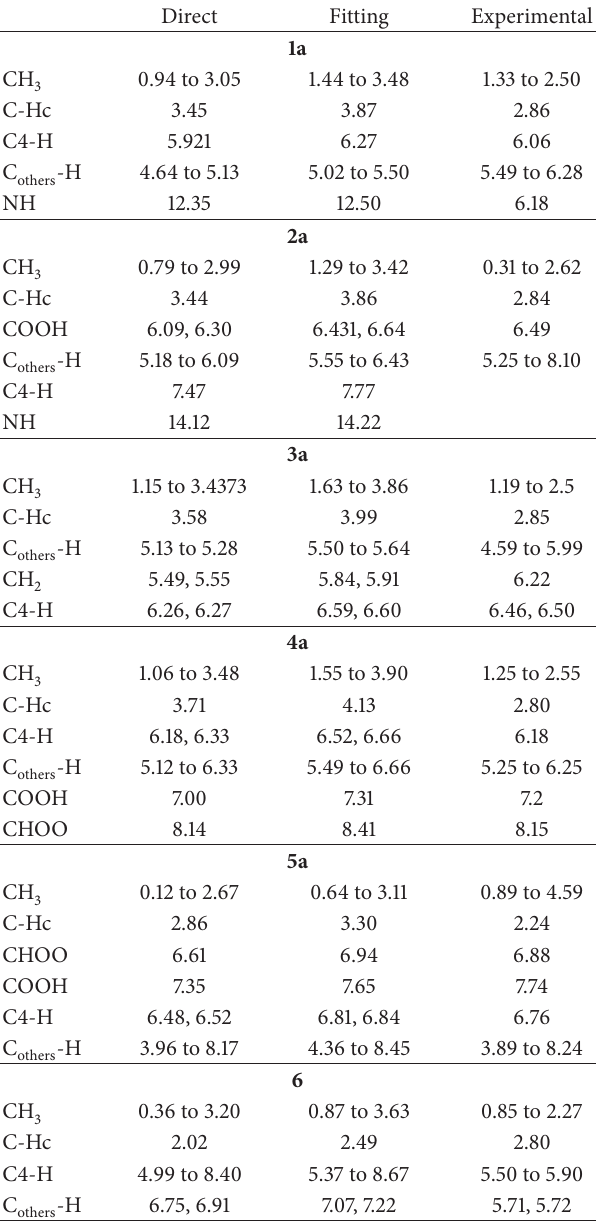
Table 3: The experimental and the theoretical (direct and fitting) of the 1 H-NMR of the complexes in ppm.